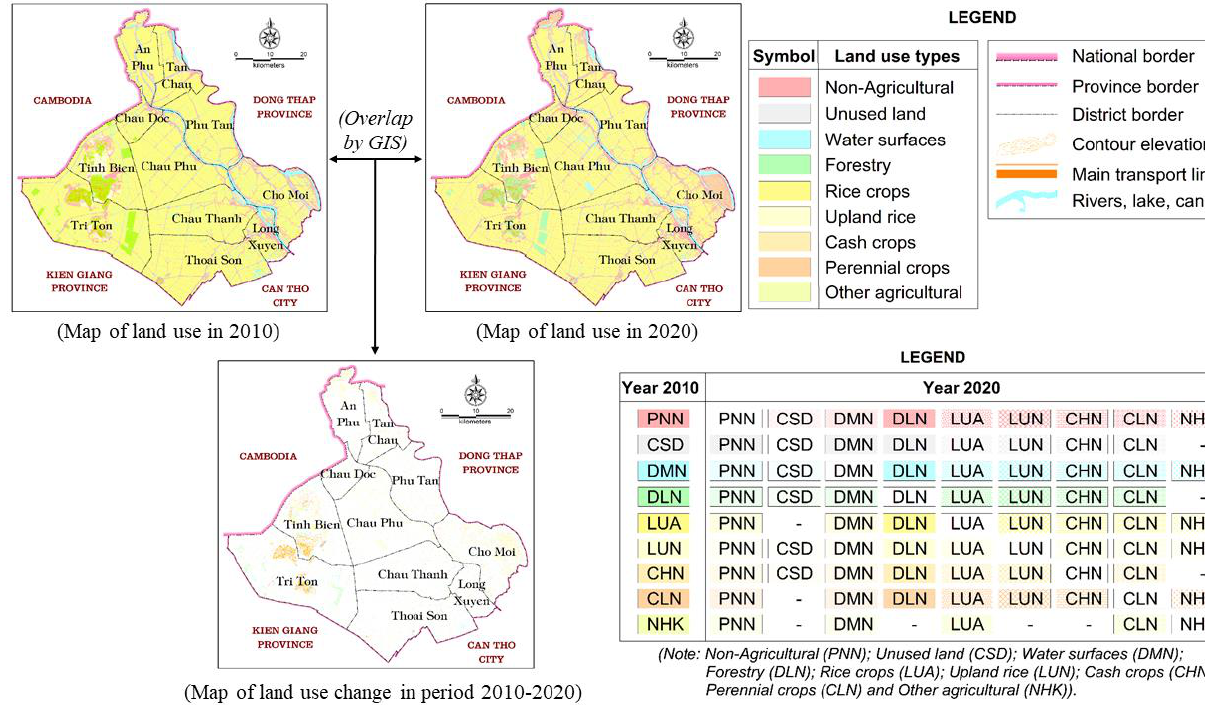
Figure 2. The overlap diagram for determining the land use change area for the period of 2010 to 2020.